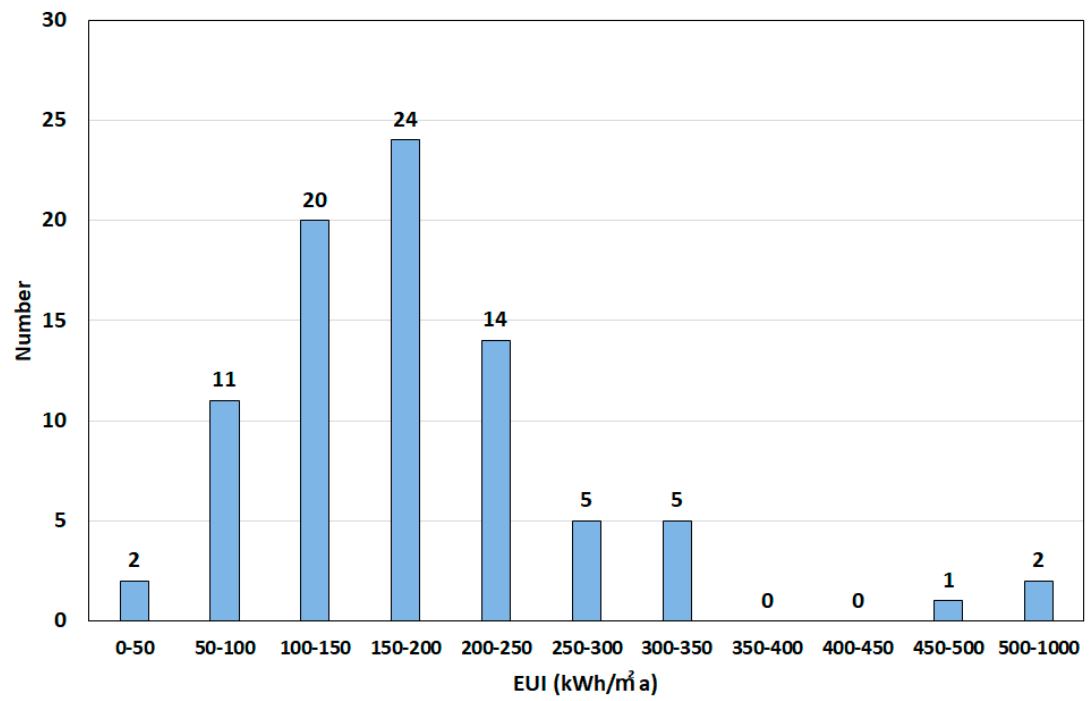
Figure 7. Number of samples by EUI distribution. Table 7. Average EUI and average total floor area by G-SEED certification